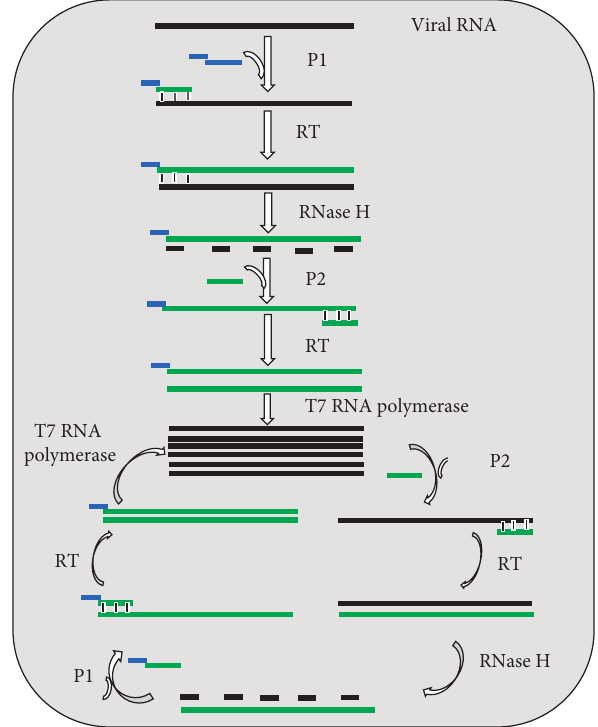
Figure 3: Schematic of the principle of NASBA. Abbreviations: P1, primer 1; P2, primer 2; RT, reverse